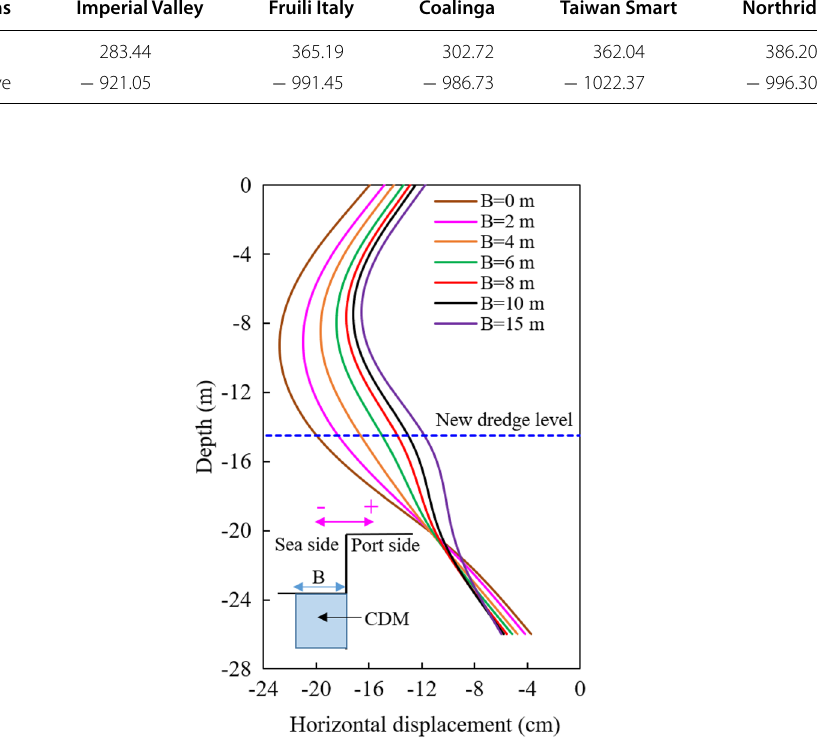
Fig. 11 Horizontal displacement of the sheet pile with different improvement areas (the Coalinga